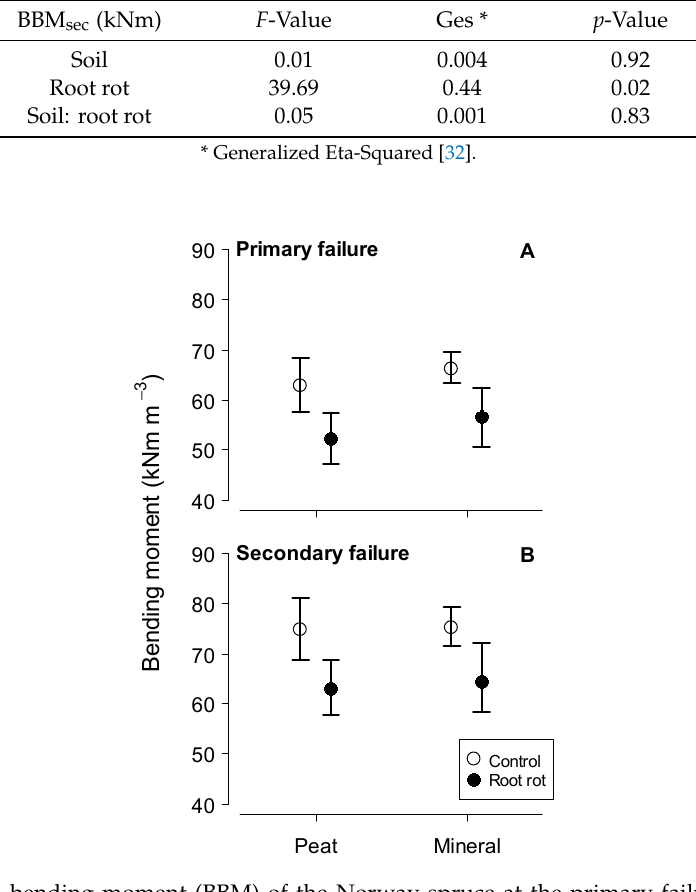
Figure 1. Basal bending moment (BBM) of the Norway spruce at the primary failure ( A ) and at secondary failure ( B ) according to stem wood volume and root rot. Table 3. Results of the fractional analysis of variance between bending moment at primary (BBM prim ) and secondary (BBM sec ) failure, soil type, the presence of root rot, and the interaction between soil type and the presence of root rot.